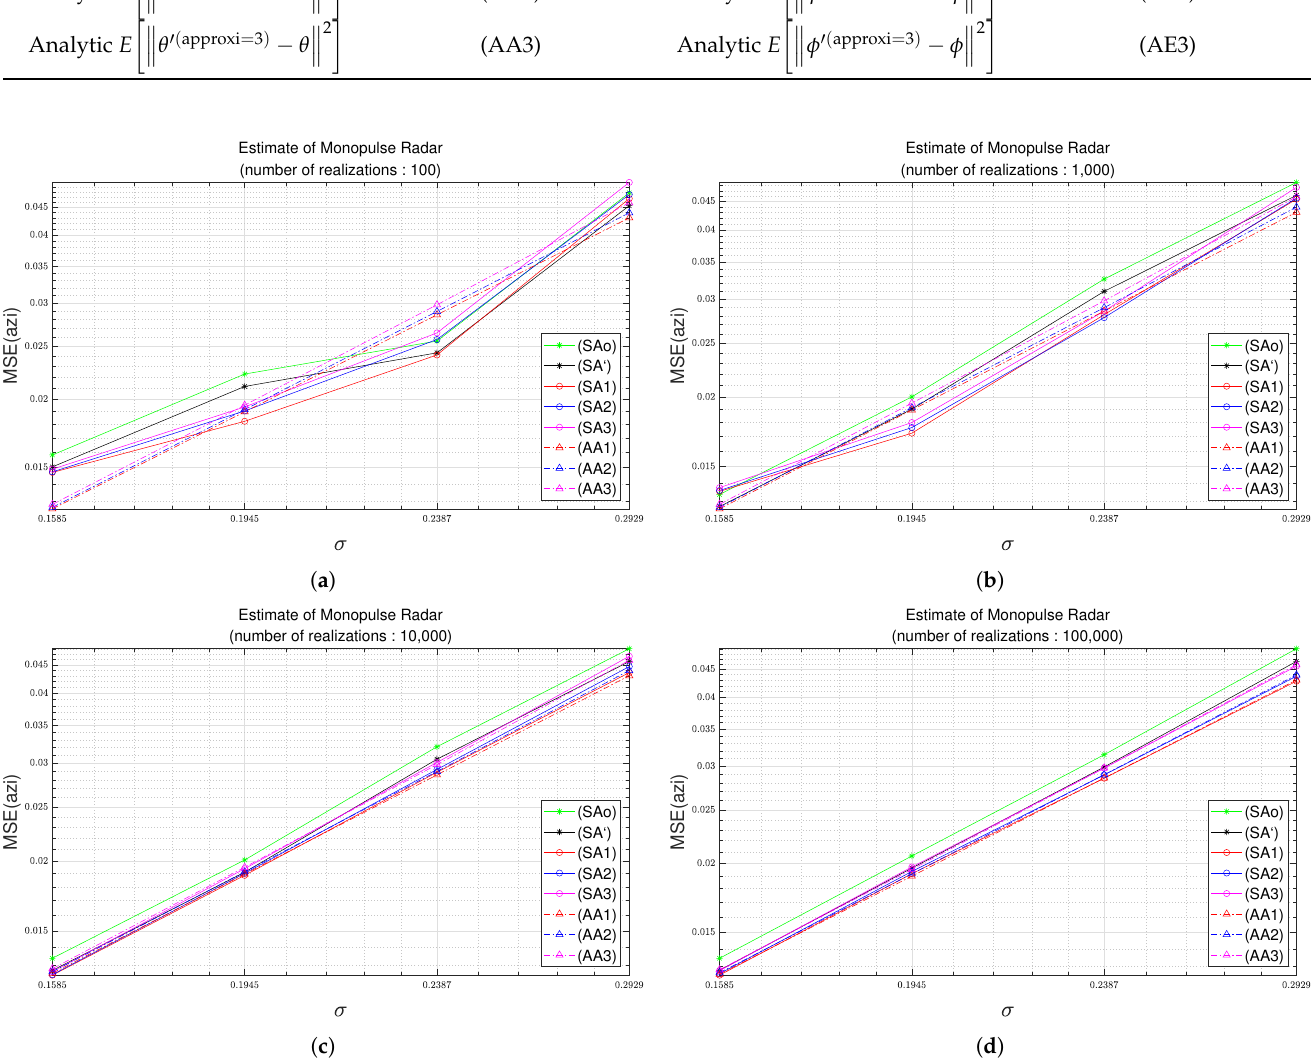
Figure 2. MSE as a function of standard deviation considering the Monte Carlo simulations with different realization